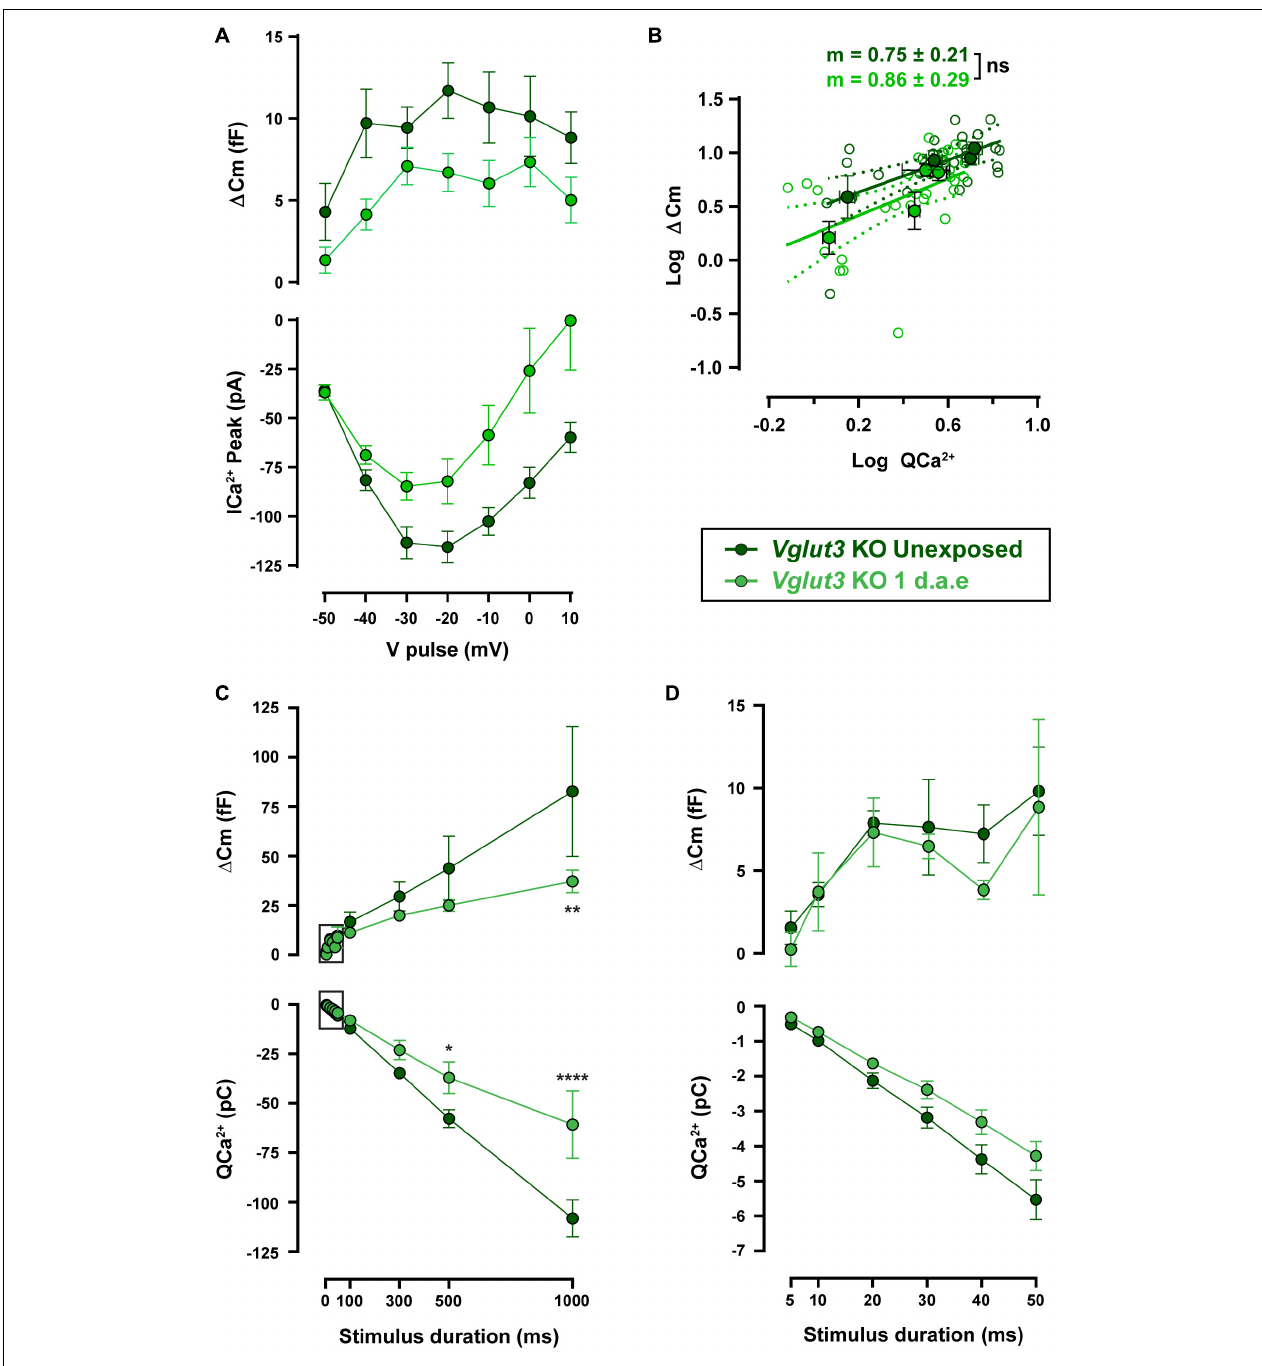
FIGURE 6 | Noise-induced increase in exocytosis capacity is absent in Vglut3 KO mice. (A) Measurement of exocytosis ( (cid:49) Cm, upper panel) and corresponding Ca 2 + current integrals (QCa 2 + , lower panel) for Vglut3 knock-out (KO) control (Unexposed, dark green traces) and 1 d.a.e. Vglut3 KO (green traces) inner hair cells (IHCs) obtained during the application of 50 ms pulses of different voltages. Statistical comparisons were made using Two-way ANOVA followed by Holm-Sidak multiple comparisons test. (B) Mean exocytic responses triggered by pulses in the range of − 50 to − 20 mV plotted vs. the mean corresponding Ca 2 + current integrals for each potential in a double-logarithmic scale. Linear regressions were fitted as in Figure 2C and slopes of the linear fit ( m ) were calculated. Slope comparisons were made using ANCOVA test. (C) Exocytosis ( (cid:49) Cm) and Ca 2 + current integrals (QCa 2 + ) corresponding to − 20 mV pulses of different durations for experimental groups mentioned above ( n = 6 for both groups). (D) Expansion of panel C depicting the exocytosis and calcium entry triggered by − 20 mV pulses between 5 and 50 ms. Data is presented as mean ± standard error of the mean (SEM). Statistical comparisons were made using Two-way ANOVA followed by Holm-Sidak multiple comparisons test. * p < 0.05, ** p < 0.01, **** p < 0.0001. Data is shown as mean ± SEM.